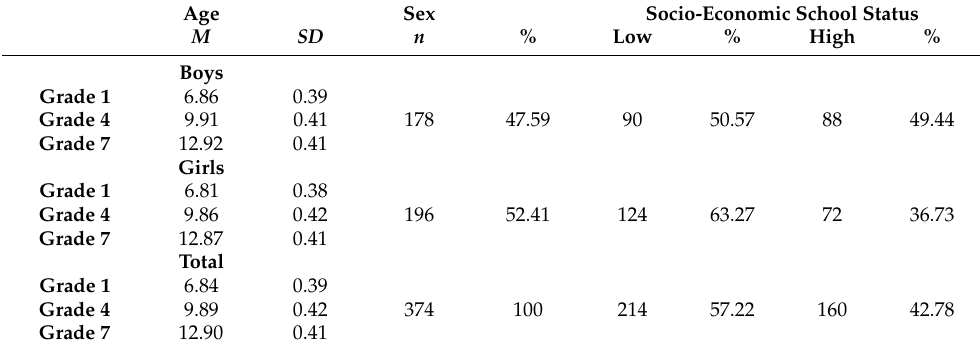
Table 1. Characteristics of the participants per gender and socio-economic school status ( n = 374). Age Sex